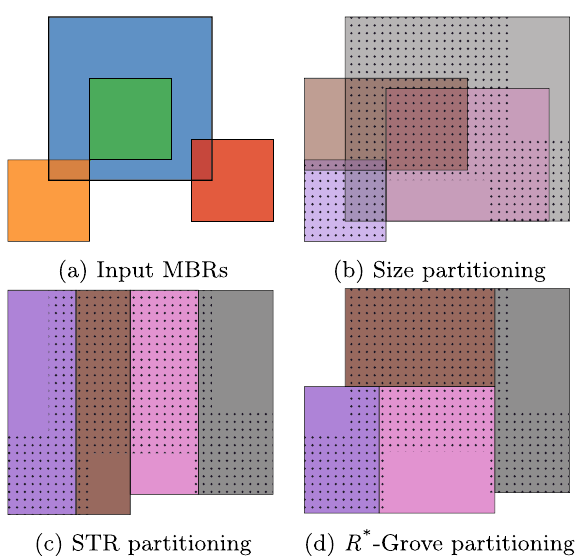
Fig. 6 Examples of three partitioning algorithms from the same input. Points are uniformly distributed in each of the four input MBRs and are marked with dots in the three partitioned